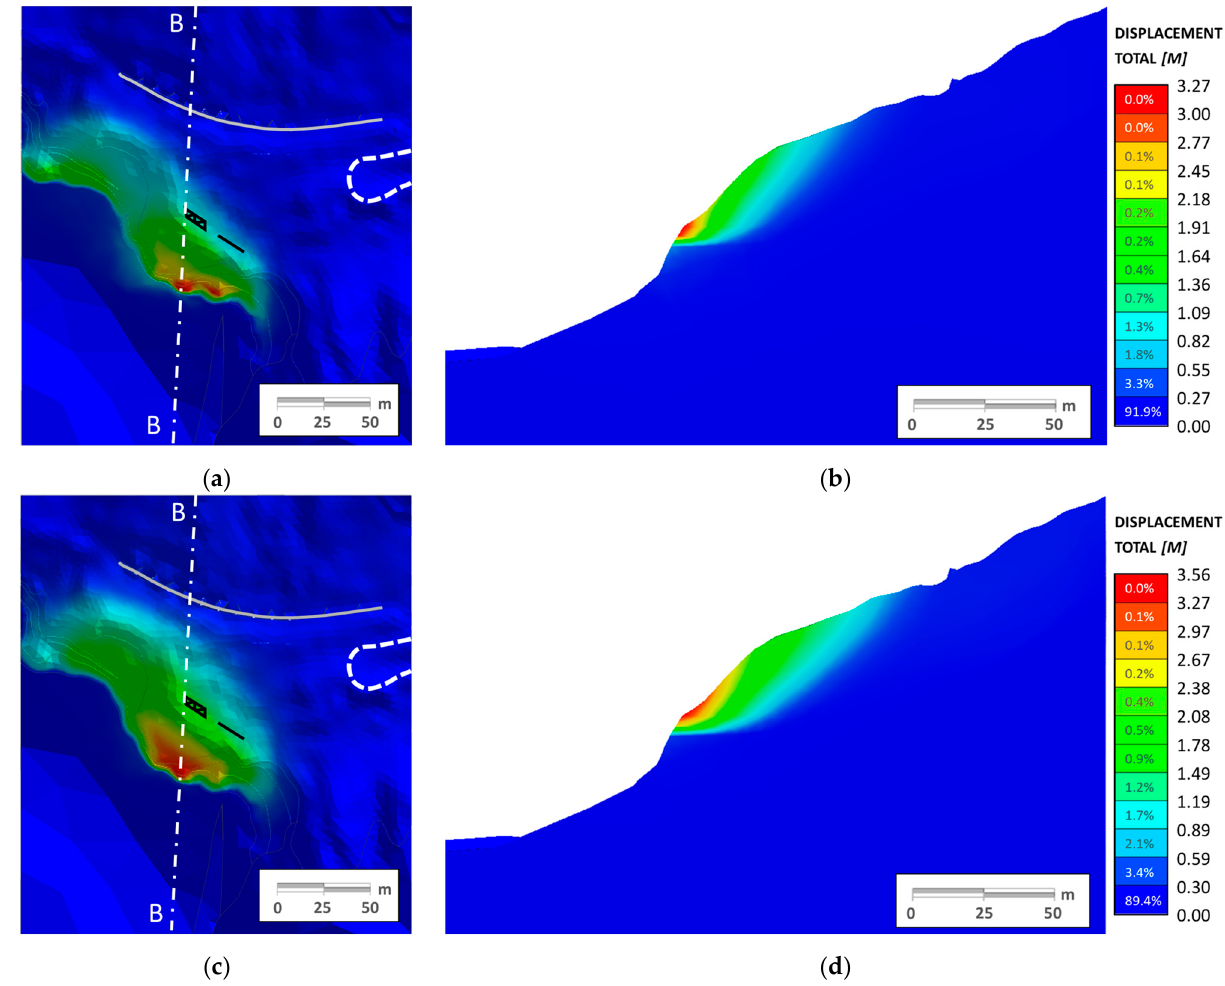
Figure 7. ( a ) Contour plot of the total displacements in wet configuration (FS = 1.002); ( b ) section B–B; ( c ) contour plot in dry conditions (FS = 1.17); ( d ) section B–B.